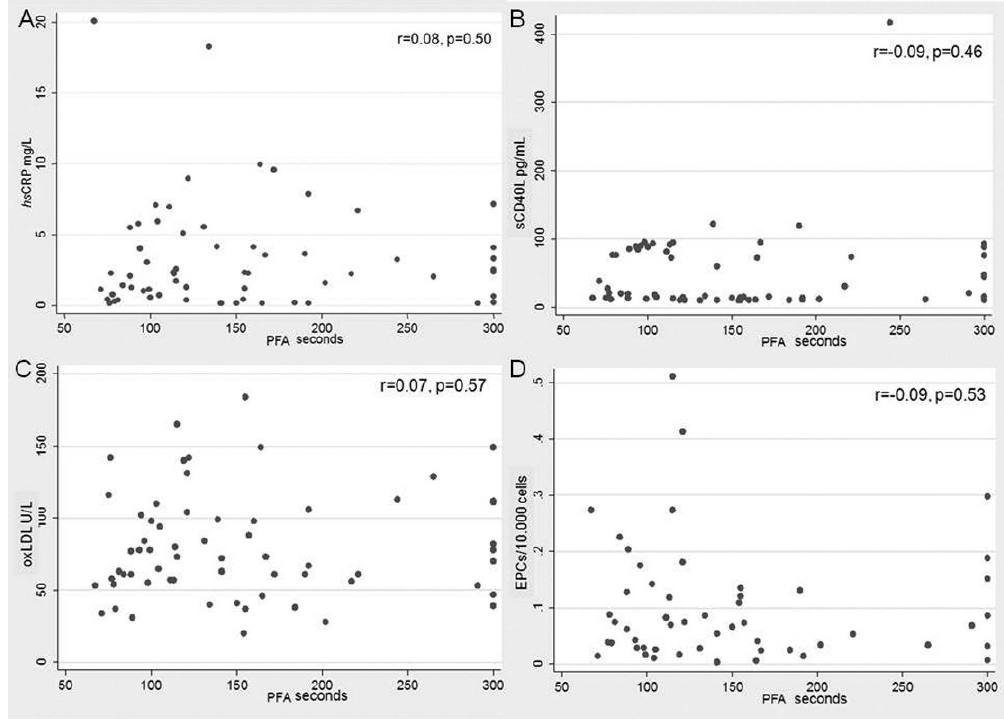
Figure 2 - Correlations between the platelet function analyzer (PFA)-100 and the levels of (A) high-sensitivity C-reactive protein ( hs CRP), (B) soluble CD40 ligand (sCD40L), (C) oxidized low-density lipoprotein (oxLDL), and (D) endothelial progenitor cells